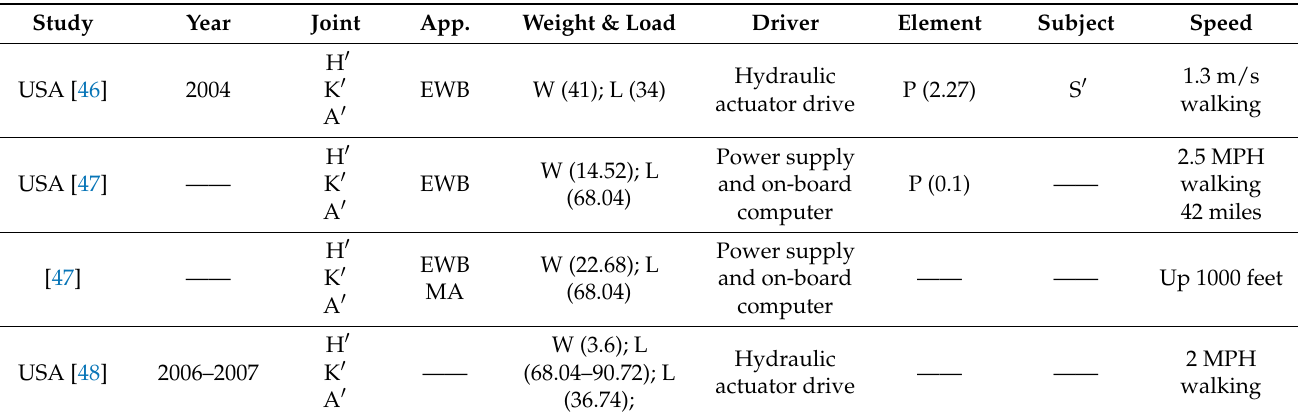
Table 2. Powered lower limb multi-joint assisted